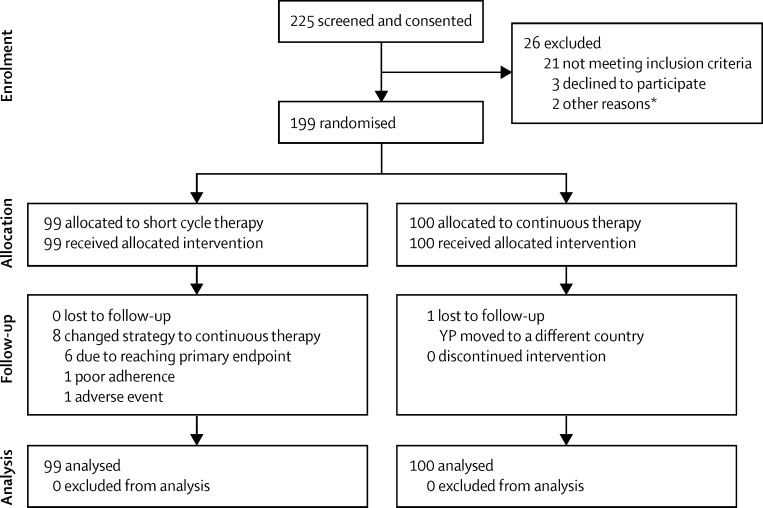
Trial profile*One participant was unable to attend the randomisation visit due to a traffic accident and another participant was excluded because of unreliable attendance.